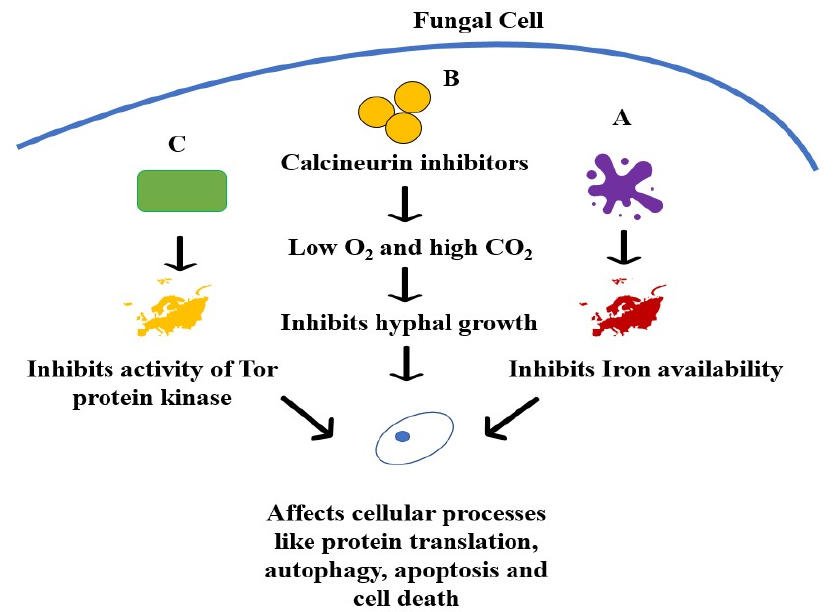
Figure 2. Drug action mechanism of ( A ) Deferasirox, ( B ) Calcineurin Inhibitors and ( C ) Rapamycin on the fungal cell.